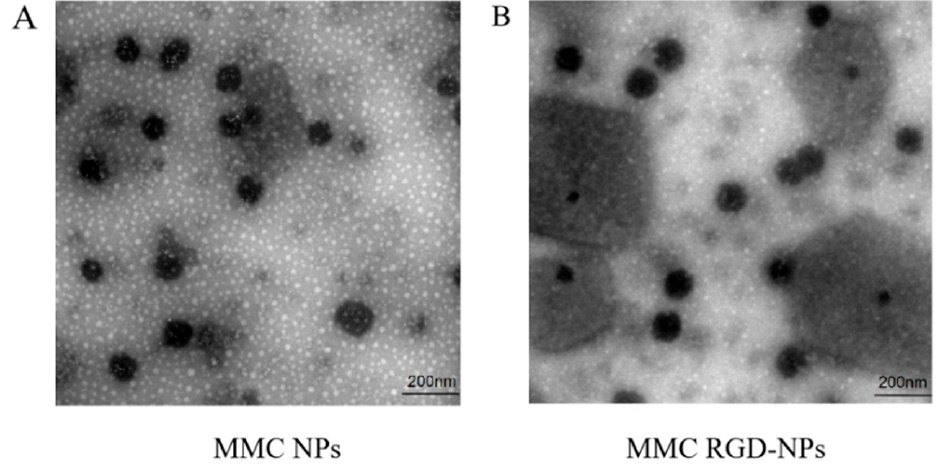
Figure 3. TEM image of MMC NPs ( A ) and MMC RGD-NPs ( B ).